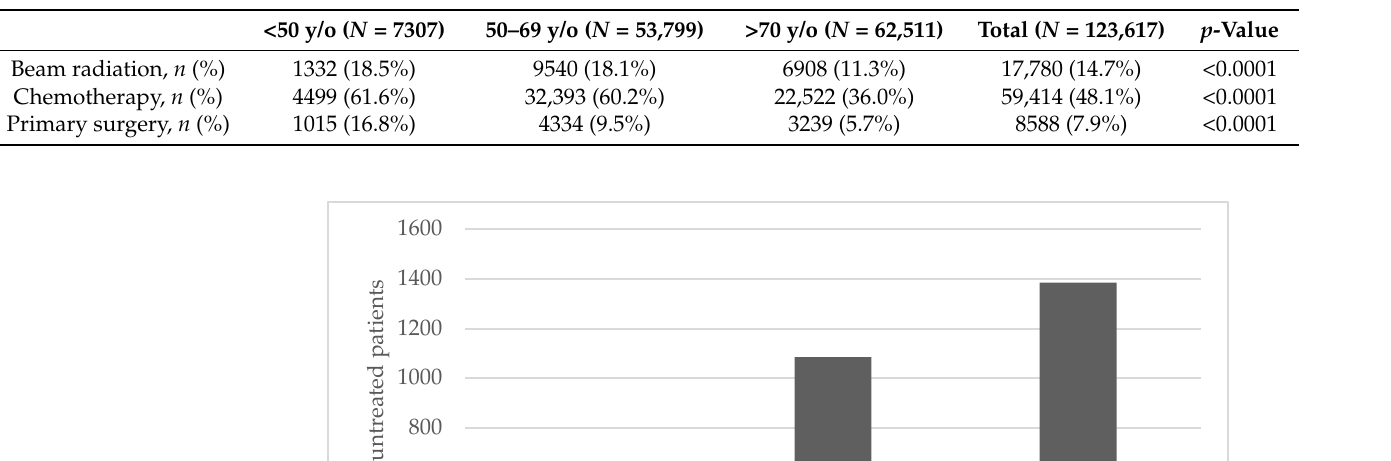
Table A1. Treatment Patterns by Age Groups.